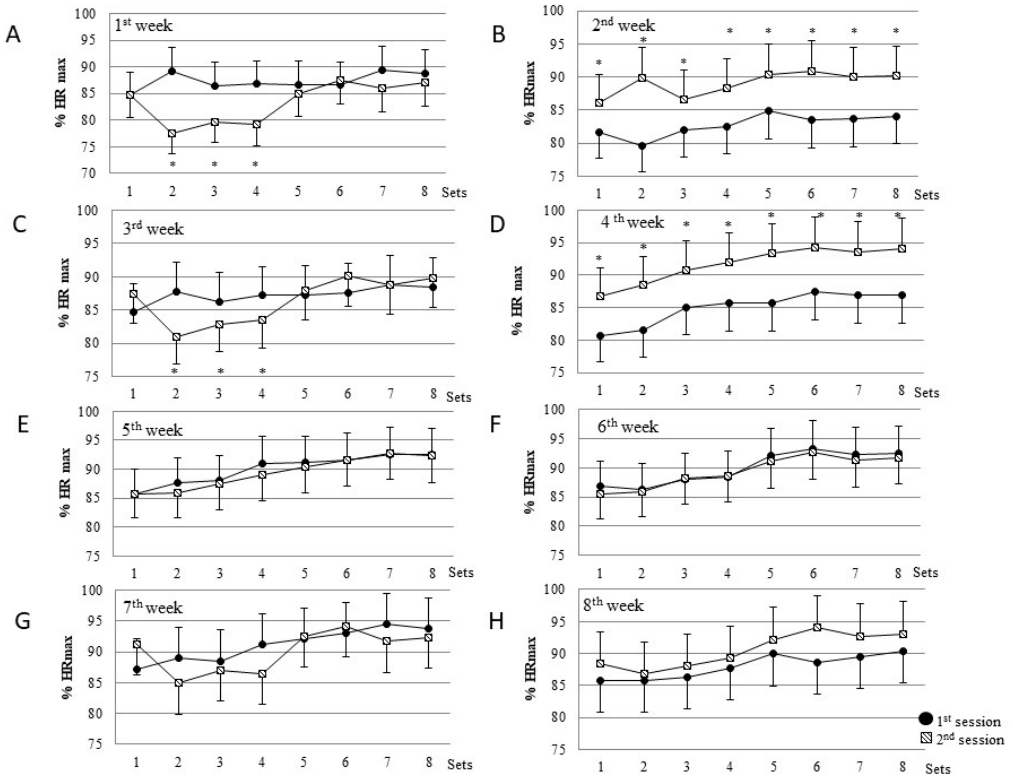
Figure 2. Mean intensity of eight sets in each training session during eight weeks training expressed as % HR max . ( A – H ) present the intensity of all eight training sets during the first session in the week (black circle) and second session in the week (dotted square) * p < 0.05 in comparison to the same sets during the first training session (Student’s t-test). HR = hart rate.